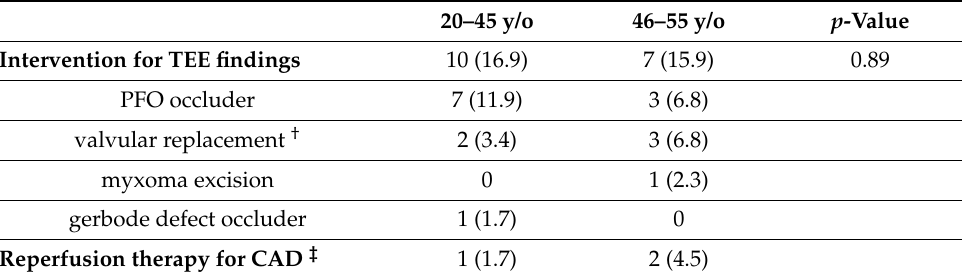
Table 3. Cardiac interventions after cardiologist consultations and